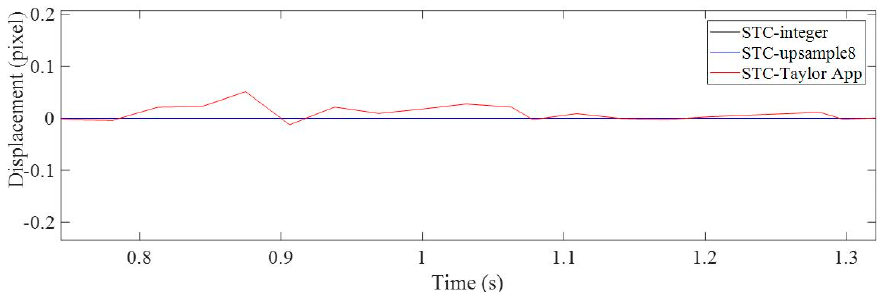
Figure 9. A zoomed in section at the beginning of the vertical displacement time histories of P1.